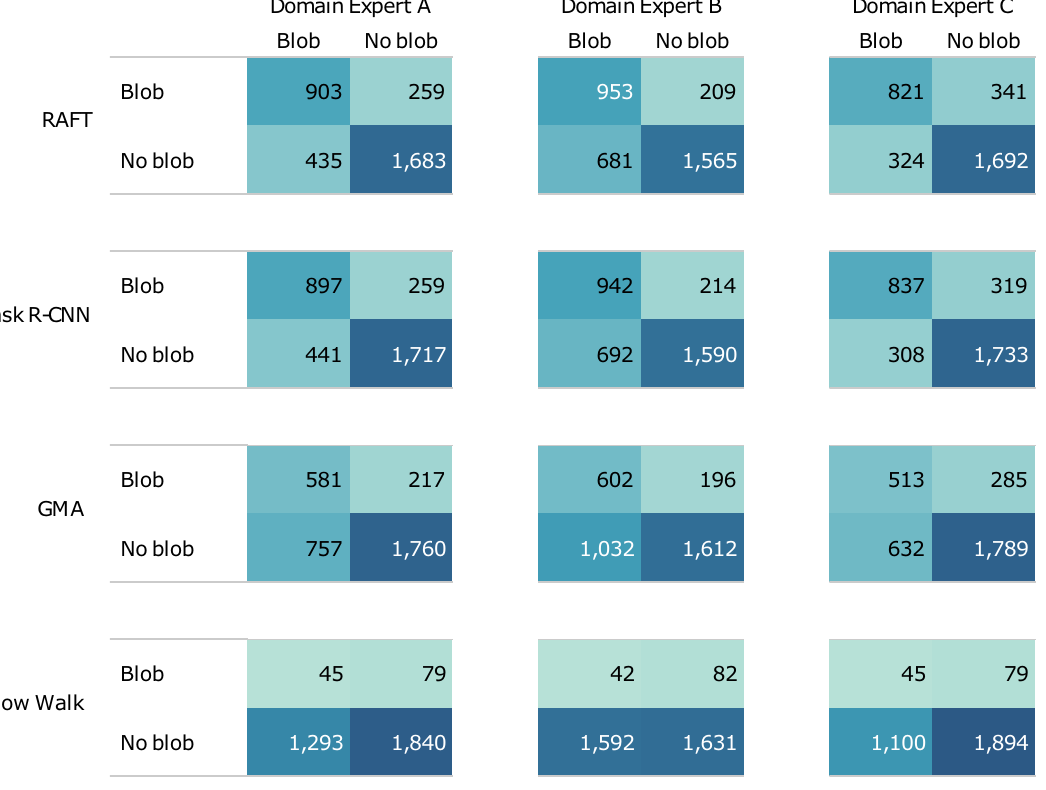
Figure 6. Confusion matrices of the four methods (RAFT, Mask R-CNN, GMA, and Flow Walk), for the real GPI data with 3000 frames hand-labeled by three domain experts ( A – C the diagram in Figure 7. Here, (cid:31) (a normalized blob size) and (cid:31) (a normalized plasma collisionality, which is proportional to the electron-ion collision frequency) are defined as in 9,10